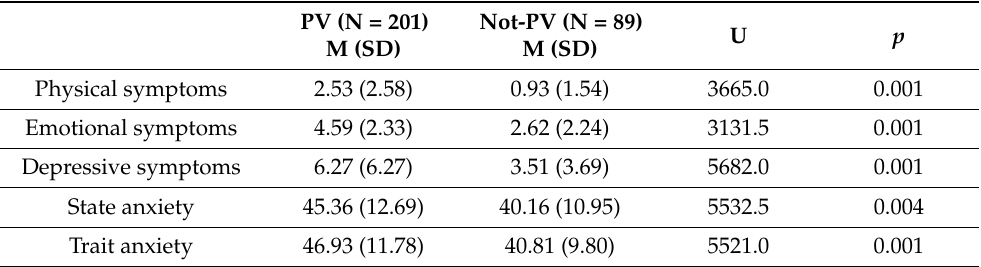
Table 3. Physical and emotional consequences, depressive symptoms, state and trait anxiety: compar- ison between PV and Not-PV.